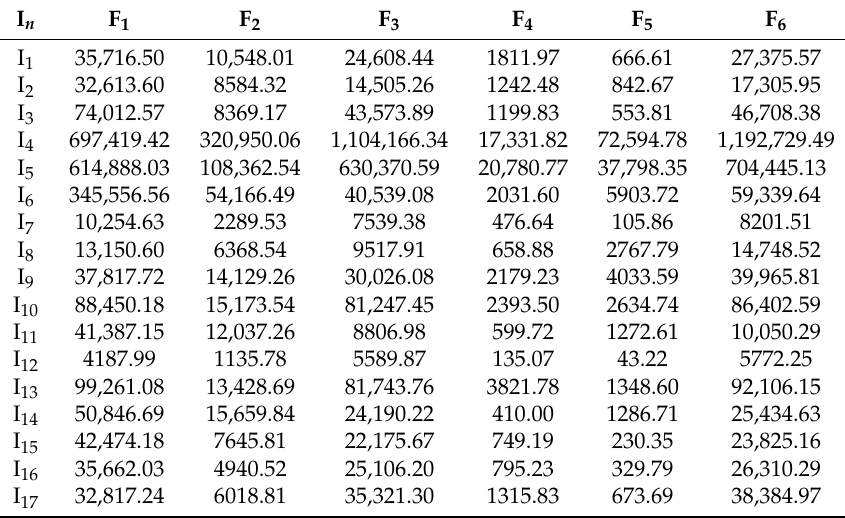
Table 6. Data in